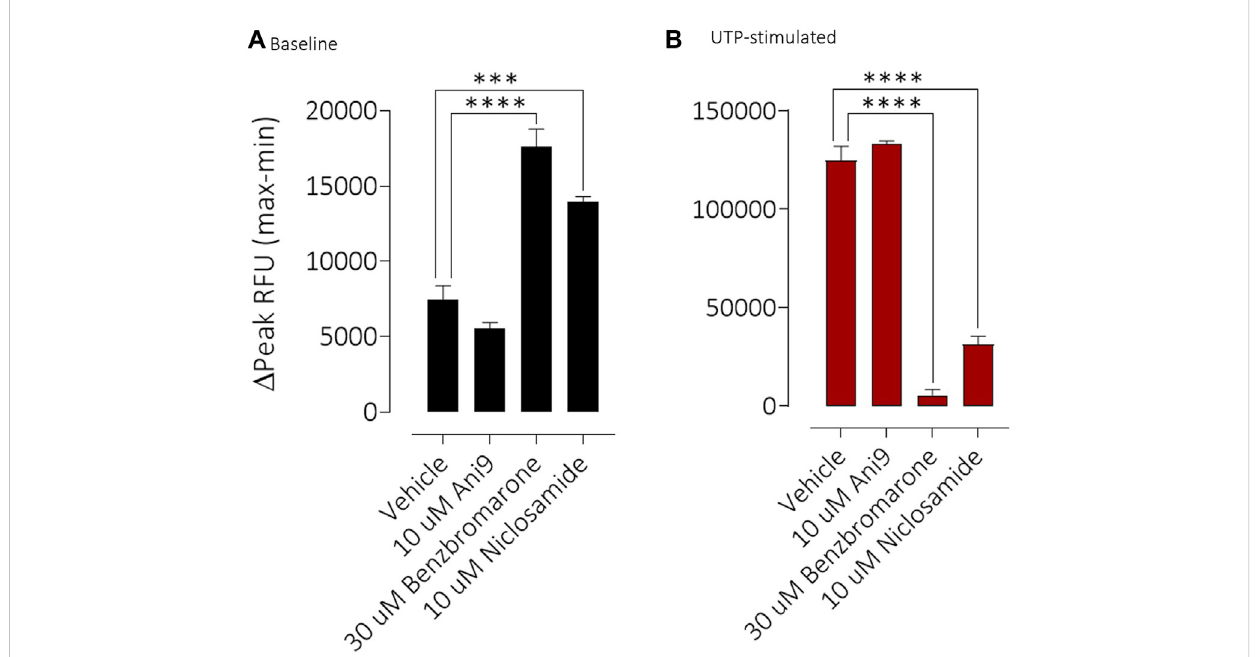
FIGURE 5 Benzbromarone and niclosamide affect calcium handling in differentiated cystic fi brosis human bronchial epithelial (HBE) cells. Mean data ±SEM illustrating the direct effects of Ani9, benzbromarone and niclosamide on [Ca 2+ ] i (A) and also on the increases in [Ca 2+ ] i stimulated by a maximal concentration of UTP (B) in CF-HBE. Peak changes in fl uorescence minus the baseline levels are plotted for the effects of each compound under both conditions. Mean data ±s. e.m. (4 – 10 inserts per group). *** and **** denote p < 0.001 and p < 0.0001